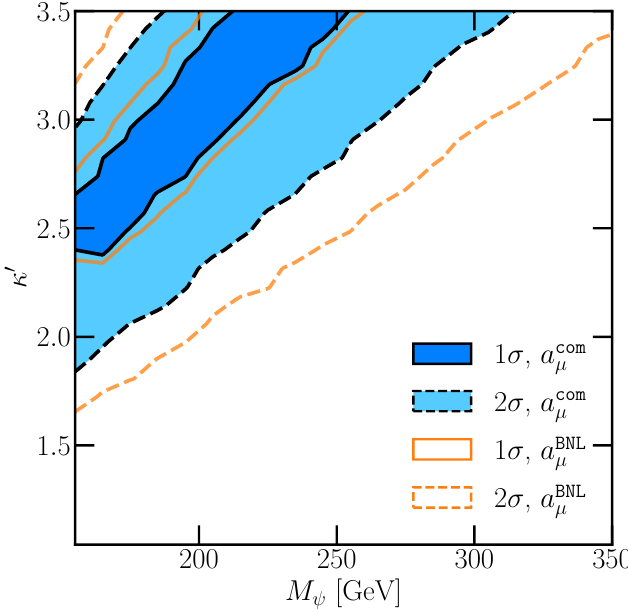
Figure 2 . The VLML mass M ψ vs. κ 0 . The inner and outer contours are 1 σ (solid) and 2 σ (dashed) confidence limits, respectively. The orange unfilled and blue filled contours correspond to the previous BNL ( g − 2) data and the combined one from BNL and the recent E989, respectively. µ In addition to ( g − 2) , all the other constraints are µ